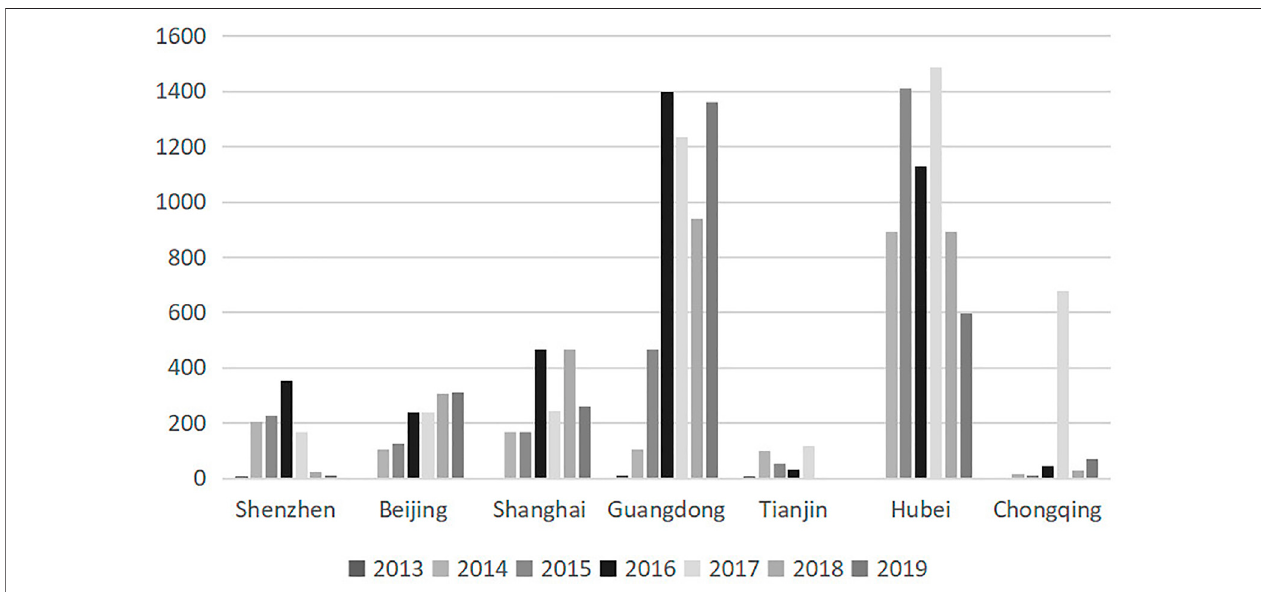
FIGURE 1 | Trading Volume of Carbon emission rights in the seven Pilots 2013 – 2019. Notes: (unit: 10,000 tons of CO 2 equivalent). Source: China Carbon Emissions Trading Network.